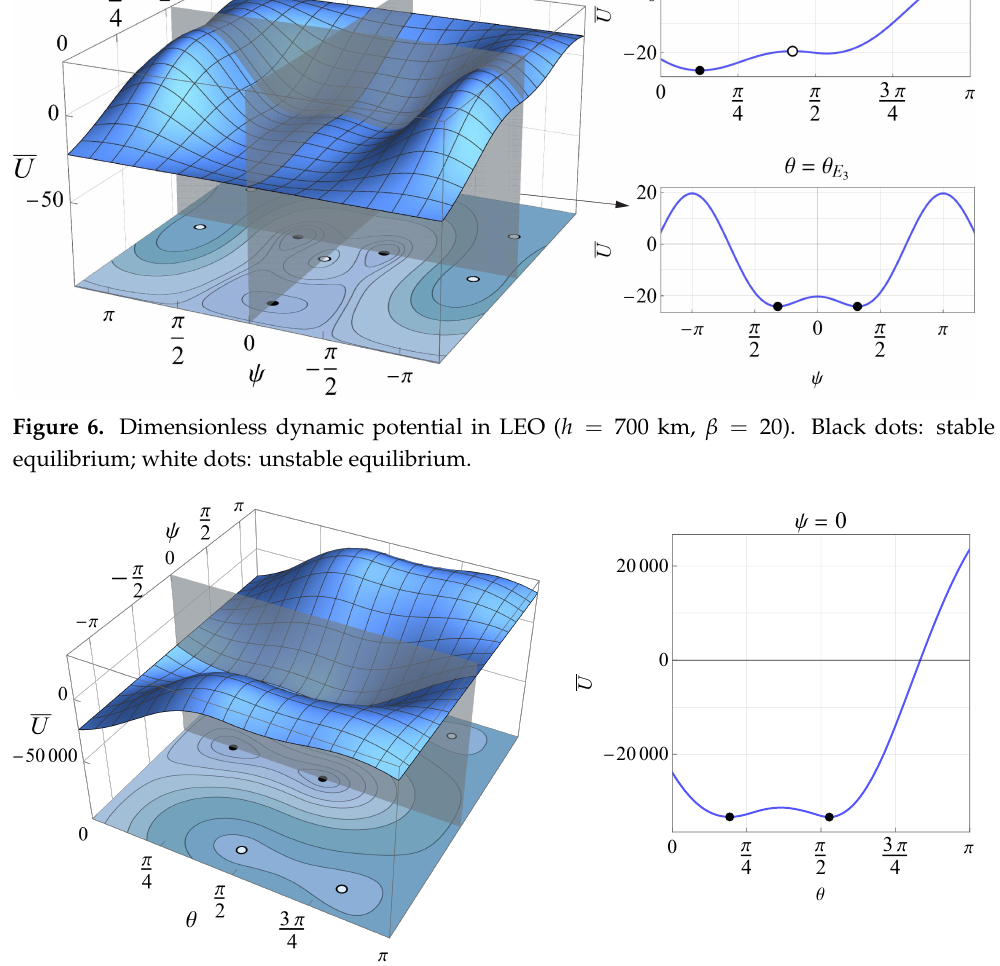
Figure 7. Dimensionless dynamic potential in VLEO ( h = 250 km, β = 33,000). Black dots: stable equilibrium; white dots: unstable